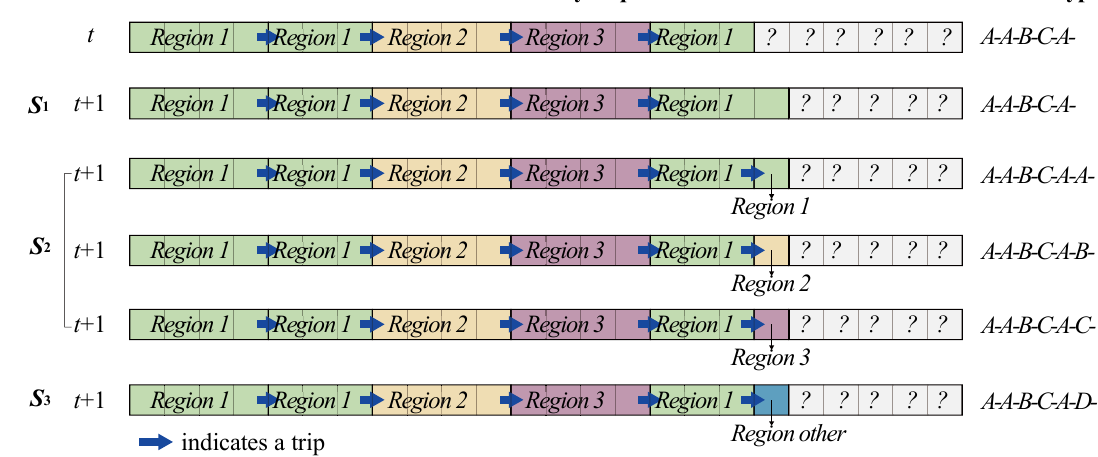
Figure 8. Flowchart of reproducing human mobility.